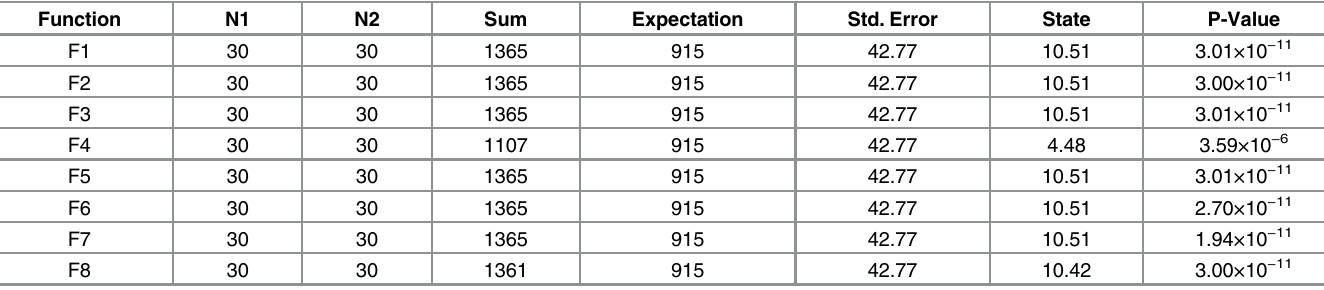
Table 5. Wilcoxon's rank-sum test between GSA and ECGSA for benchmark functions.